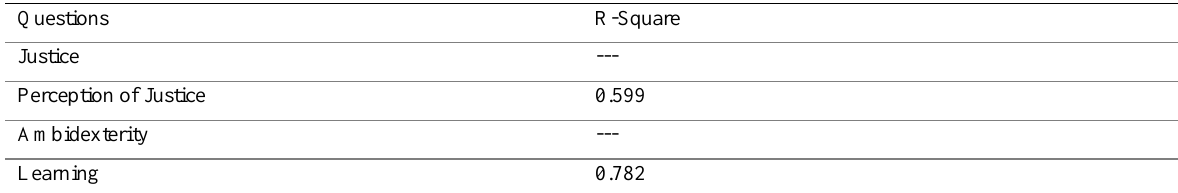
Table 5: R-Square Value Table (R-Square)